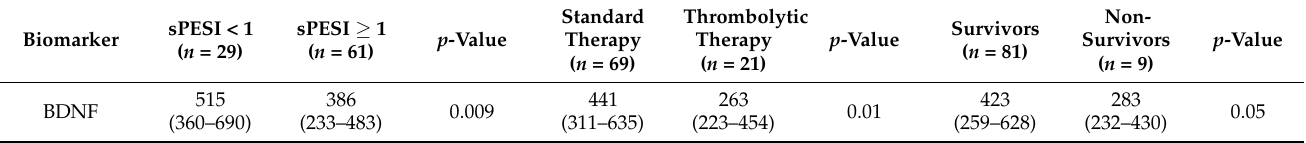
Table 6. BDNF profile according to risk category.